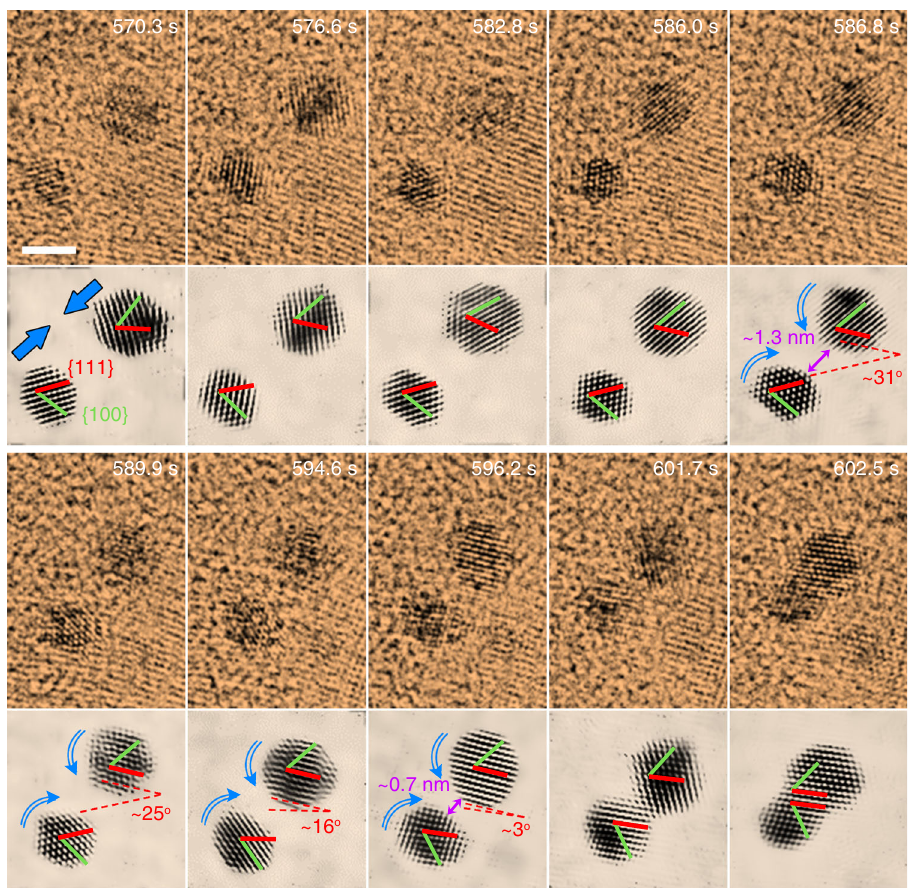
Fig. 1 Imaging of OA at atomic level. Video sequences from Supplementary Movie 3 showing the OA process of small gold nanoparticles at {111} surface, evolving into a twin structure. The sequences below each false color TEM image are corresponding fi ltered images that highlight the evolution of particle orientations during OA, and also show the approaching of particles and the establishment of pre-alignment by rotation, after which the jump to contact occurs. In general, pre-alignment takes about tens of seconds while jump to contact is accomplished in less than 1 s. Red lines stand for {111} facets and green ones for {100} facets. Dashed lines depict the relative angle between the {111} facets of the two particles. The direction of movement of the particles (approaching and rotation) is denoted by blue arrows. Scale bar, 2